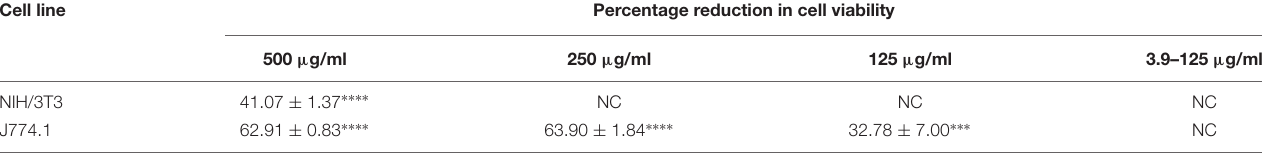
TABLE 3 | In vitro cytotoxicity of SBT348 extract and SKC3 on cell lines. Cell line